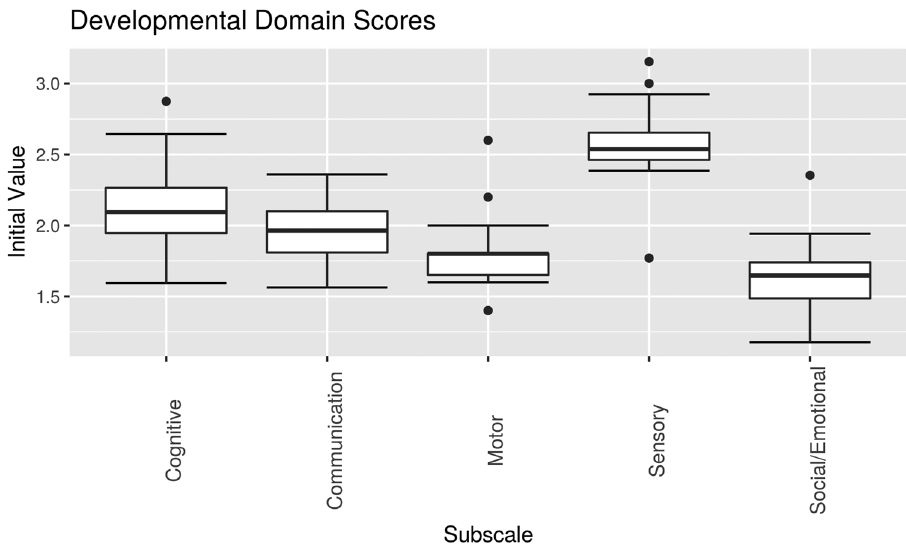
Figure 6: Box plot showing distribution of initial scores on the domain scales.